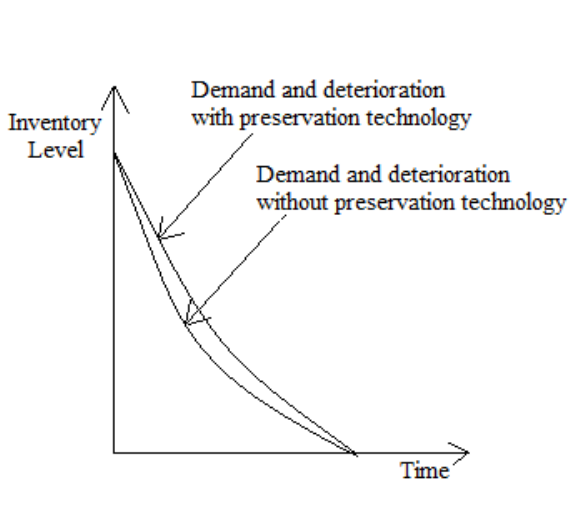
Figure 2. Graphical representation of inventory